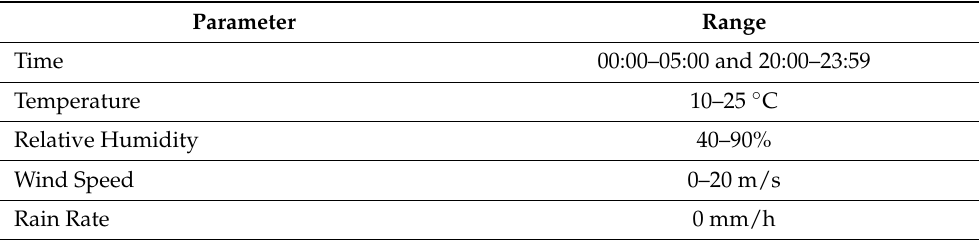
Table 2. Weather conditions during